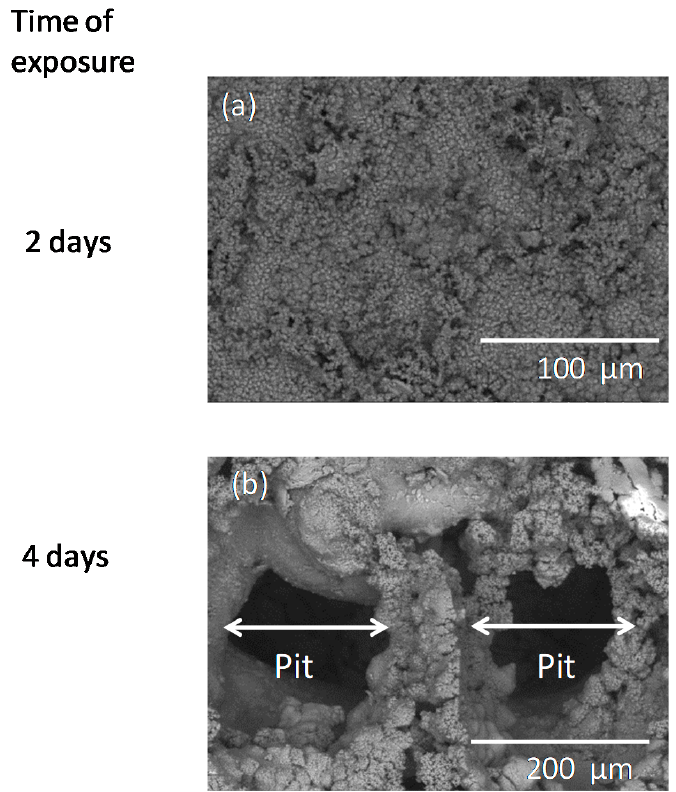
Figure 1. ( a ) BSE images showing AZ31B surface after immersion in Ringer’s solution (37 ◦ C) for 2 days; ( b ) 4 days.